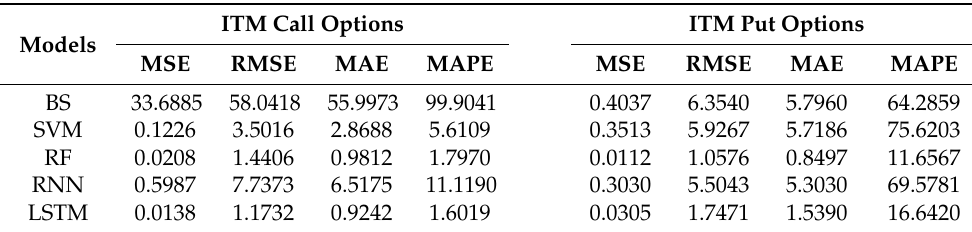
Table 11. Pricing error of ITM options estimated using different models when using realized skewness and realized